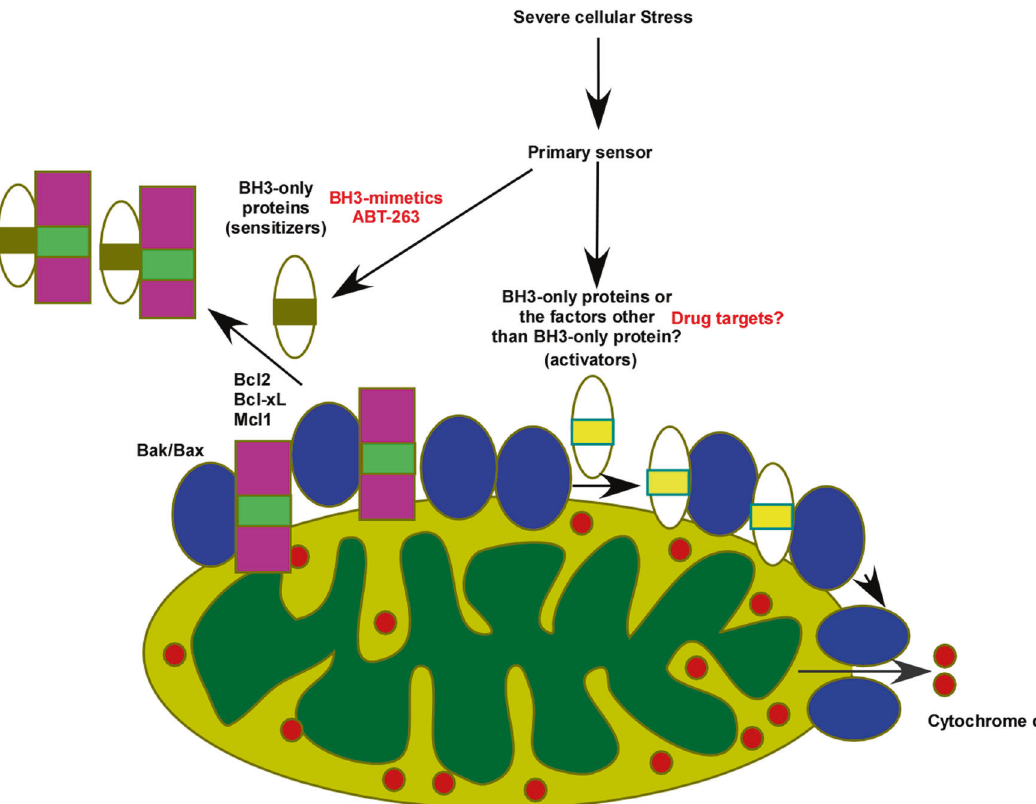
Fig. 2 The dual control model for MOMP. In response to severe cellular stress, sensitizers might disentangle Bax/Bak from anti-apoptotic proteins such as Bcl2 or Bcl-xl and then activators might prompt the formation of Bax/Bak pore for MOMP in p53-independent manner. These sensitizers might be BH3-only proteins, nevertheless these activators might be also BH3-only proteins or the factors other than BH3-only